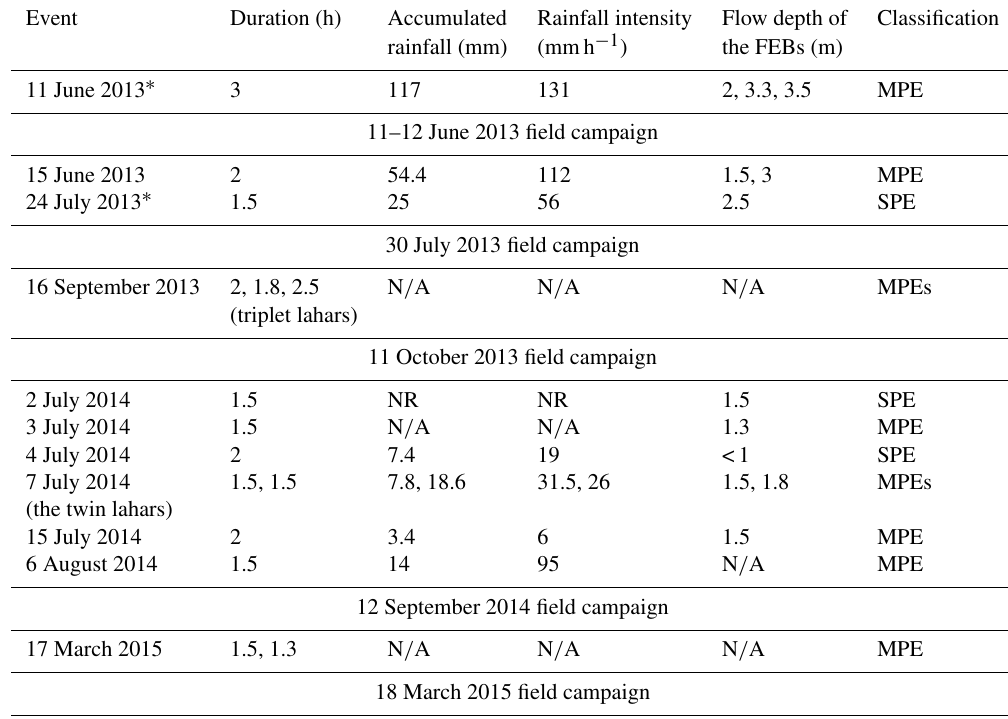
Table 1. Classification and features of the lahars that developed during the 2013 and 2014 rainy seasons, along with the first lahar of the 2015 season, on Montegrande